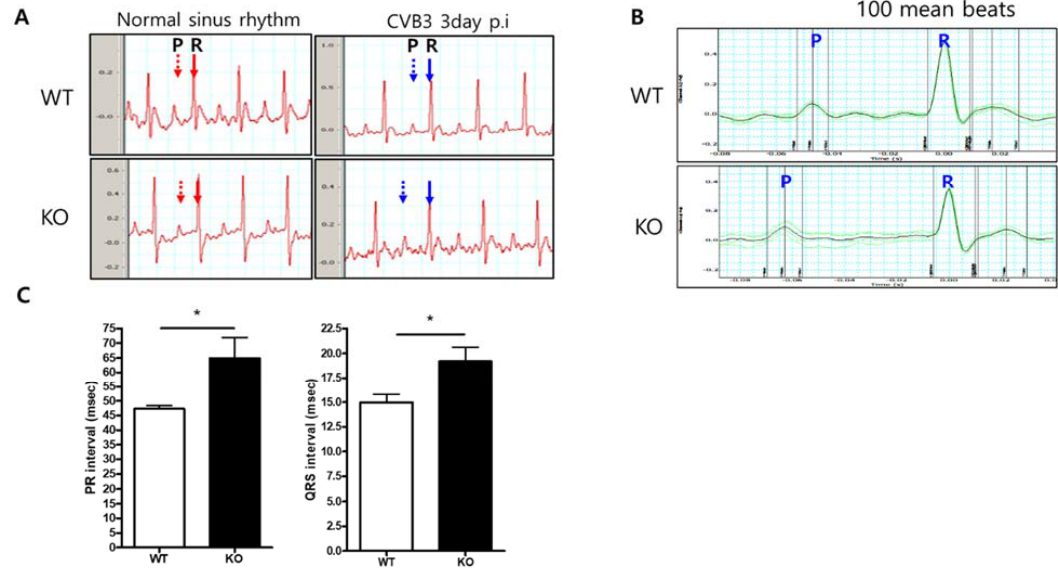
Figure 4. AKT2 deletion prolonged PR interval in CVB3-induced myocarditis. ( A ). Electrocardiogram (ECG) recorded on Day 3 p.i. The PR interval is extended in AKT2 KO mice (blue arrow). ( B ) ECG pattern of 100 mean beats in both groups of mice. ( C ) PR interval and QRS duration, measured by LabChart8.0 software. All data are the means ± s.e.m. * p < 0.05 according to a two-tailed Student’s t -test.